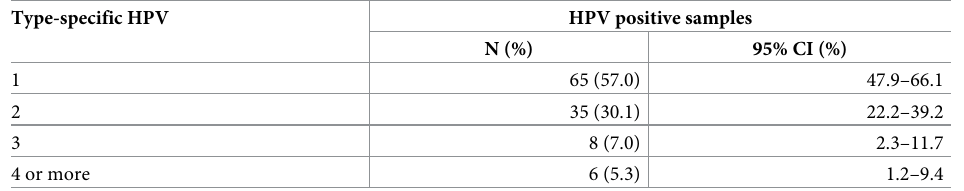
Table 2. Frequency of single and multiple HPV infections (n =